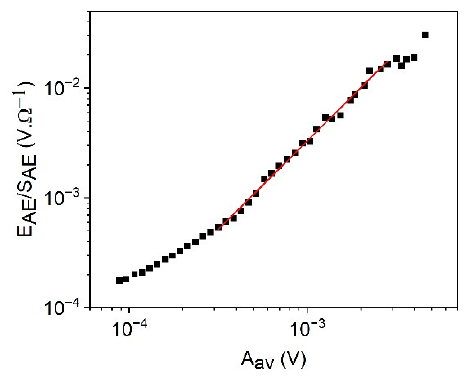
Figure 5.    versus   plot for heating in alloy B (at B = 0).